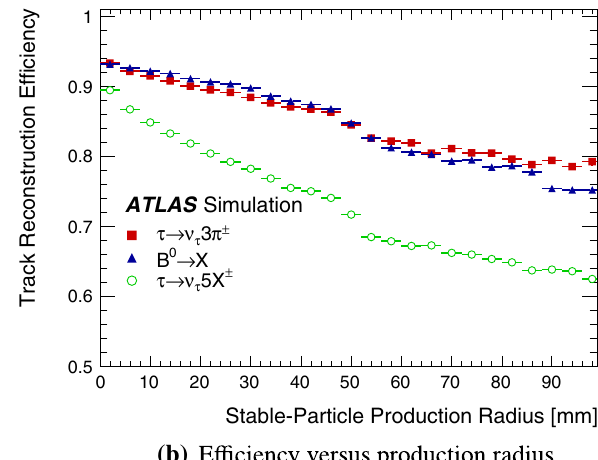
prong τ and a B 0 and, b versus the production radius for the decay products of a three- and five-prong τ as well as a B 0 , where no require- ment is imposed on the production radius of stable charged particles